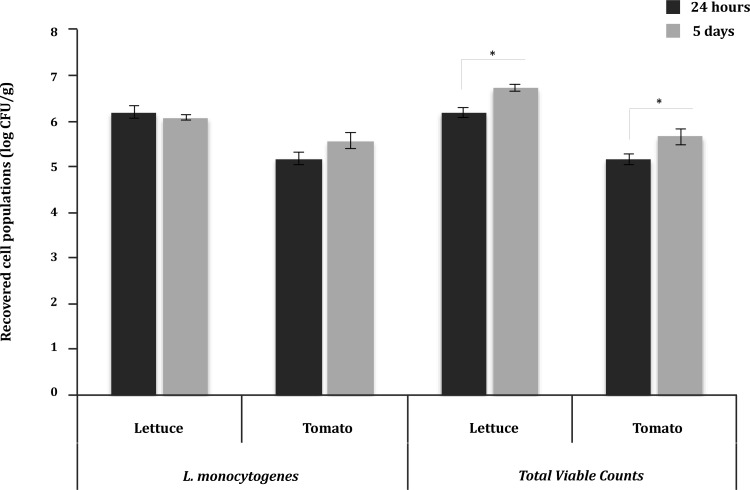
Growth of L. monocytogenes and total microbiota on fresh produce.Size of populations (log CFU/g) of L. monocytogenes and total microbiota on inoculated lettuce and tomatoes were determined following 24-h and 5-day storage at 5°C. Bars represent mean populations ± standard error mean of eight independent experiments with three technical replicates each (n = 24). Significant differences (P < 0.05) between 24-h and 5-day stored samples are shown as (*).